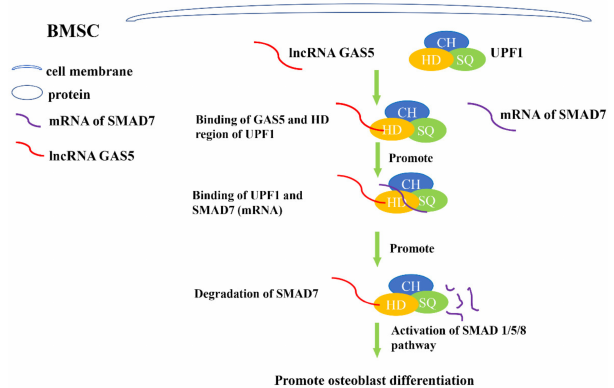
Figure 2. Schematic illustration of lncRNA GAS5 regulating osteogenesis of BMSCs by directly binding to protein UPF1. GAS5 binds to the HD region of UPF1 specifically, which results in binding of UPF1 and SMAD7 (mRNA). After binding to UPF1, SMAD7 (mRNA) degrades. As an inhibitor of the SMAD 1/5/8 pathway, degradation of SMAD7 promotes activation of SMAD 1/5/8 pathway and ultimately promotes osteoblast differentiation of